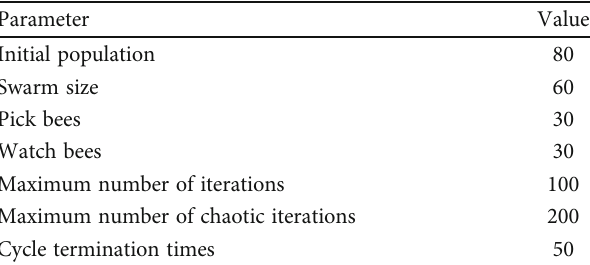
Table 6: Parameter setting of IABC-WLSSVM model.